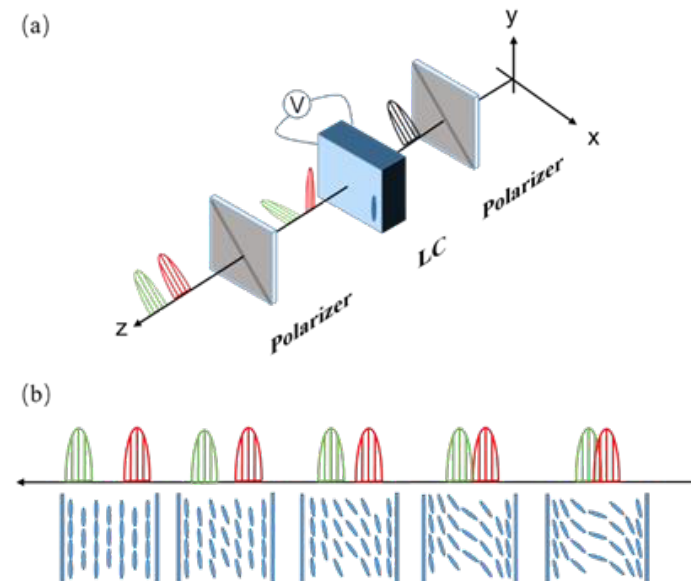
Figure 1. ( a ) Principle of measurement for the delay between the two beams provided by liquid crystal (LC). ( b ) Schematic of the relationship between the molecular deformation of the LC and the dual-beam delay during the relaxation time.